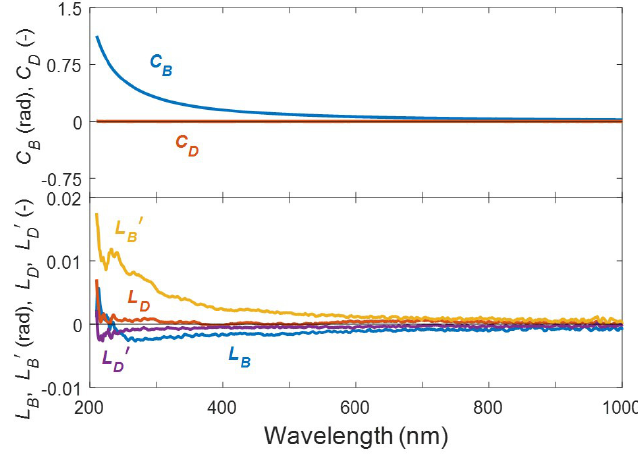
Figure 2. Birefringence and dichroism determined by differential decomposition of the MMSE data for the D-glucose solution in Figure 1. Observe the expanded scale for L B , L D , L (cid:48)